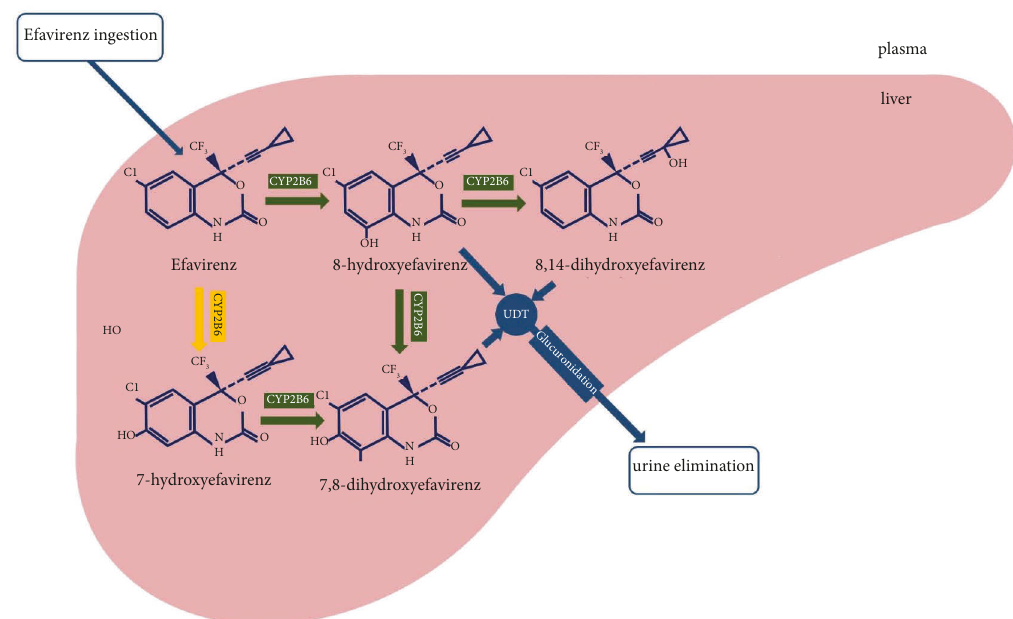
Figure 1: Schematic representation of efavirenz metabolism in the liver. It should be noted that the main route of efavirenz metabolism is 8- hydroxyefavirenz, which is predominately formed by CYP2B6. UGT, uridine 5 ′